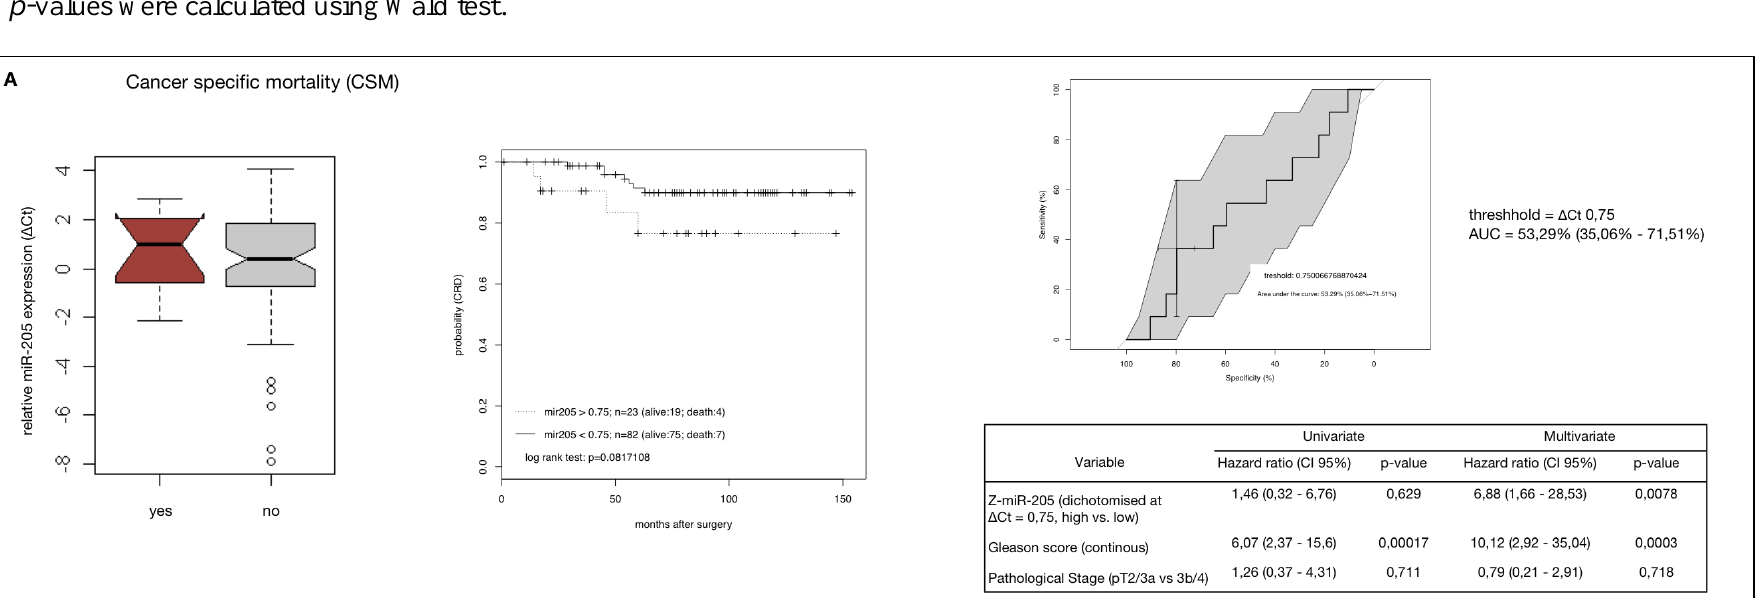
Figure 4. MiR-205 as a prognostic marker in a HRPCa study cohort ( n = 105) for the clinical endpoints ( A ) Cancer-specific mortality (CSM); ( B ) Clinical failure (CF) and ( C ) Biochemical recurrence (BCR). Left plots : boxplots showing relative miR-205 expression (Δ C t sample) in patients with and without the indicated endpoints. Middle plots : Kaplan–Meier estimates in HRPCa patients with and without the respective endpoints. Patients were dichotomised by miR-205 expression according to optimal cut-off values for each endpoint calculated by ROC ( upper right plots ). p -values were calculated using log-rank test. Lower right tables: uni- and multivariate Cox-regression analysis regarding dichotomised miR-205 expression, Gleason score and combined pT score (pT2c/3a vs . pT3b/4) for the time to the respective end-points. p -values were calculated using Wald